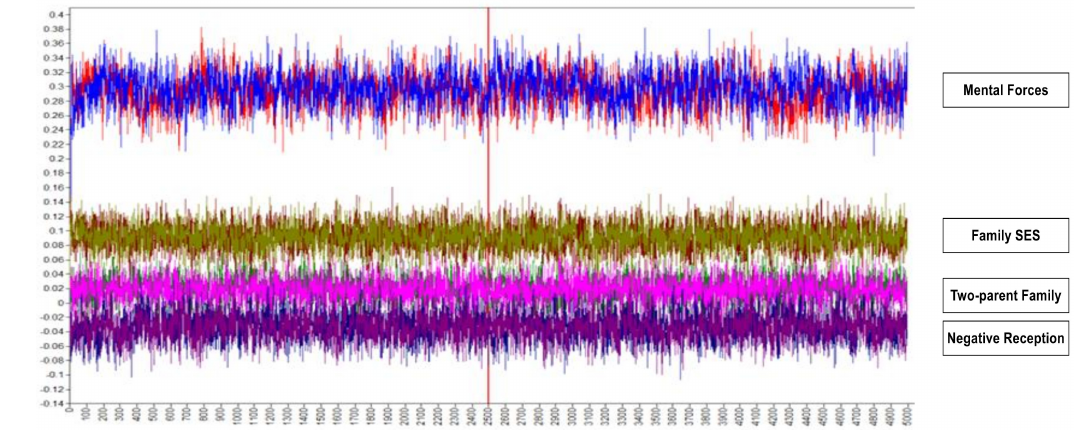
Figure A4. Bayesian posterior parameters trace plot presenting the effects of mental forces, two-parent families, family SES, and negative reception in parallel on immigrant children’s current occupational achievement. Note: The number of iterations for each Markov Chain Monte Carlo chain was modeled by setting Fbiterations = 5000 for repeated random sampling, and all individual- and school-level covariates of multilevel modeling were adjusted, PSR =